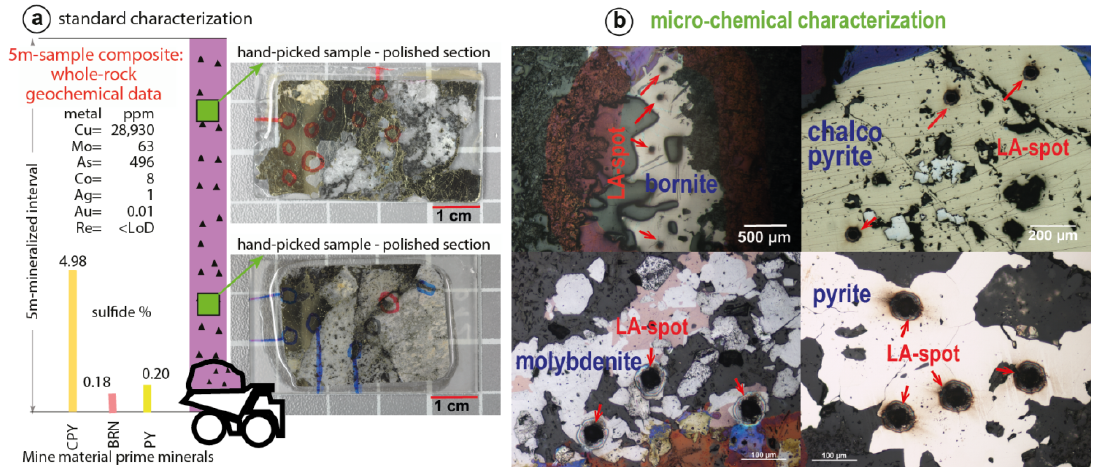
Figure 2. ( a ) Schematic diagram illustrating a selected 5 m-mineralized interval, highlighting (green filled squares) the locations of collected samples. Metal concentrations obtained from bulk analyses are indicated on the left side. Photographs of the 200 µm-thick polished sections corresponding to the hand-picked samples are shown on the right. ( b ) Photomicrographs under reflected light showing the different sulfides types analyzed by LA-ICP-MS, highlighting the locations of laser-ablation spots (LA-spot). Photomicrographs were taken after laser ablation analysis.